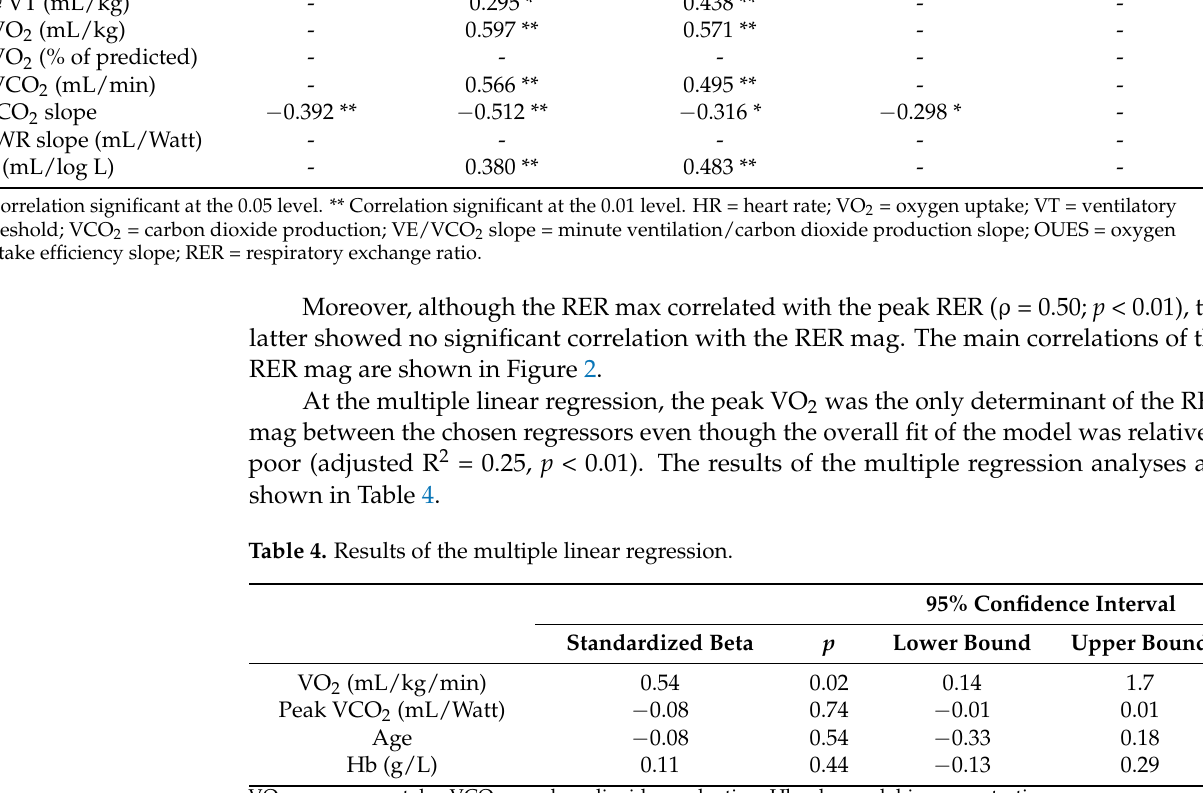
Table 3. Correlations between the RER recovery and CPET parameters expressed as Pearson’s r for the normally distributed data and Spearman’s ρ for the non-normally distributed data.